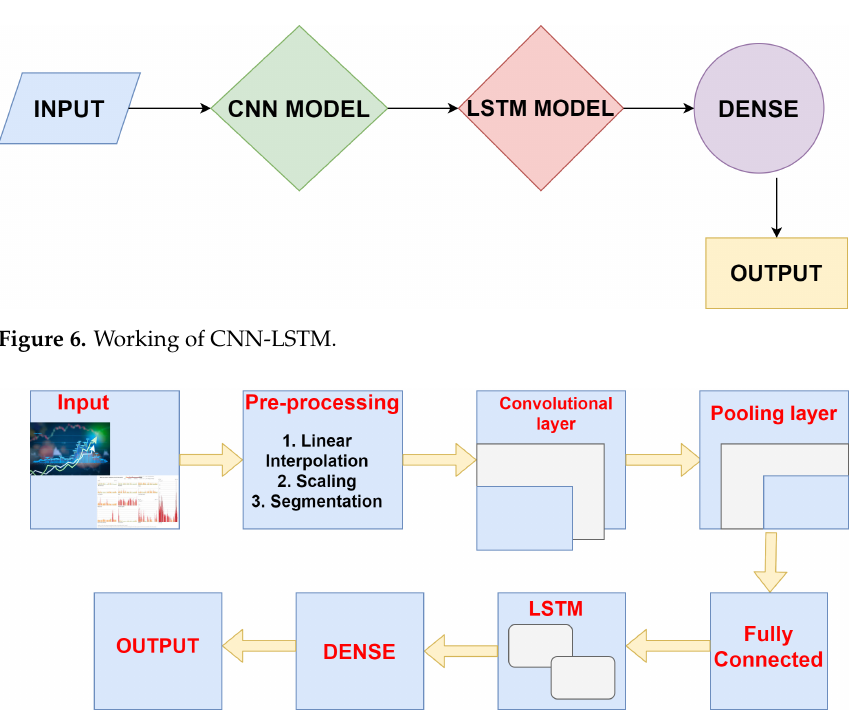
Figure 7. Efficient and lightweight deep learning